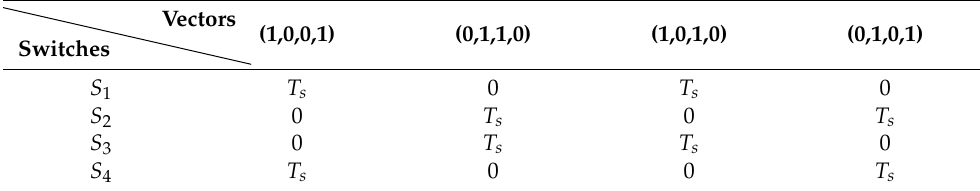
Table 2. The conduction time of each switch under FCS-MPC.